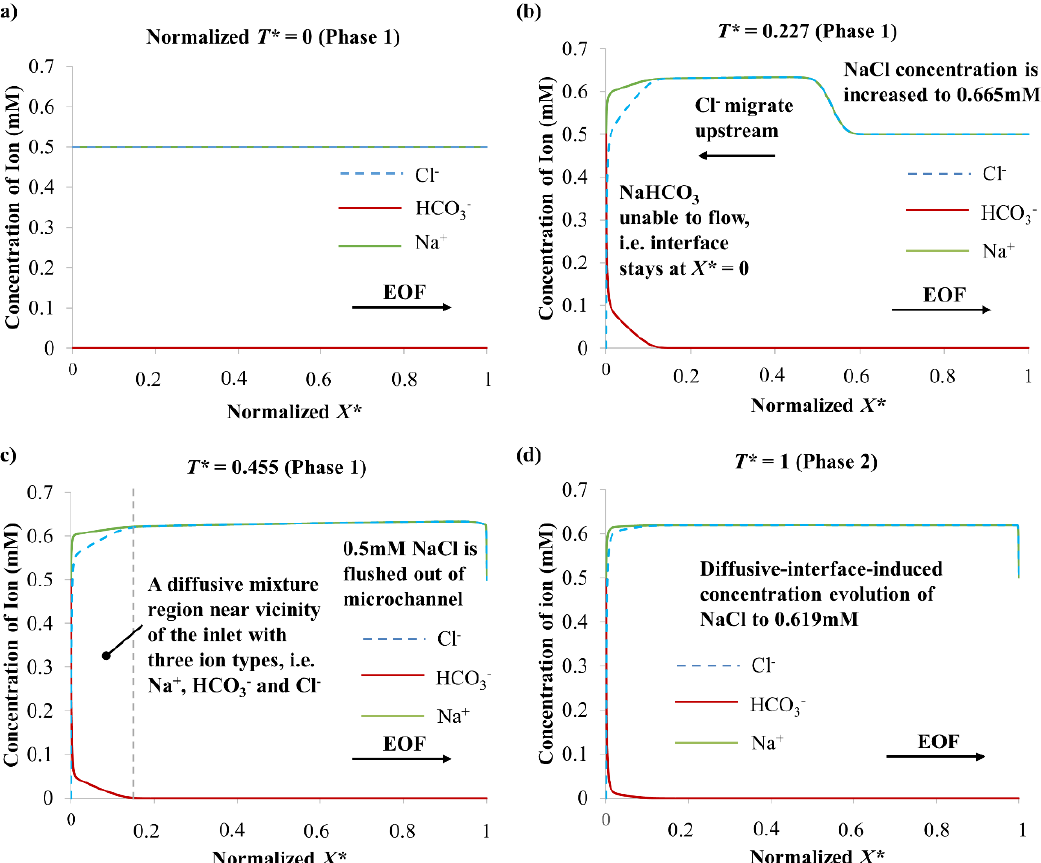
Figure 6. Numerically simulated ion concentrations along the microchannel when 0.5 mM NaHCO 3 → 0.5 mM NaCl (arrow indicates EOF direction) in ( a ) Phase 1 T* = 0, ( b ) Phase 1 T* = 0.227, ( c ) Phase 1 T* = 0.455 and ( d ) Phase 2 T* = 1. Normalized time T* = T / T SS NaCl → NaHCO 3 , where T SS NaCl → NaHCO 3 is time to reach steady-state current for NaCl → NaHCO 3 . Normalized X* = X / L , where X is axial coordinate and L microchannel length.